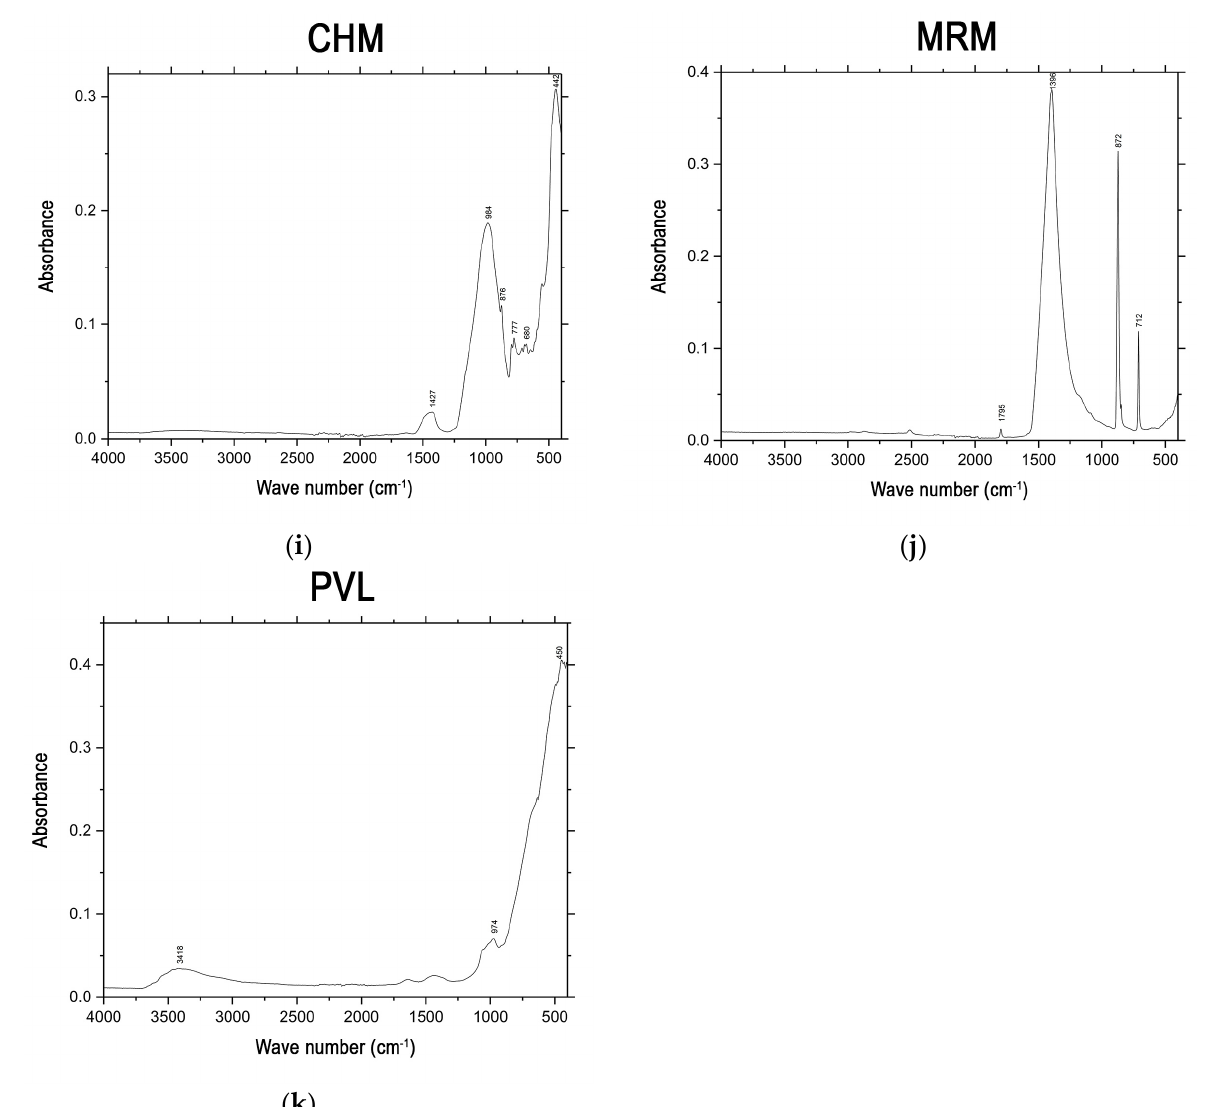
Figure 6. Infrared spectra (ATR-FTIR) of: ( a ) C_A; ( b ) C_SN_1; ( c ) C_SN_2; ( d ) C_T; ( e ) A_A; ( f ) A_N; ( g ) A_R; ( h ) Y; ( i ) CHM; ( j ) MRM; ( k ) PVL.